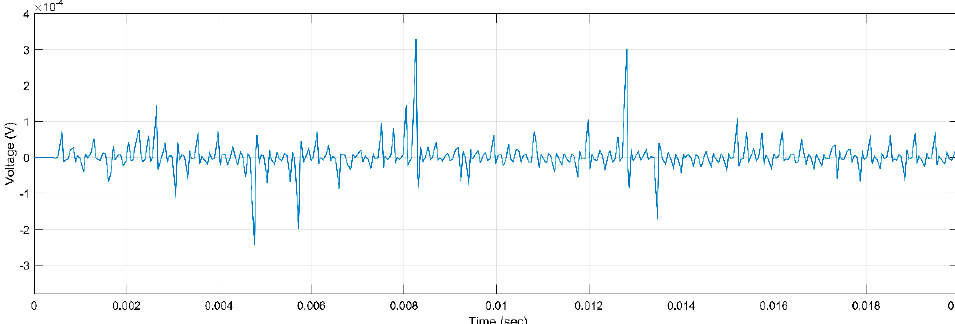
Figure 15. PD Activity for ER, 5 kV, 2 h, r.